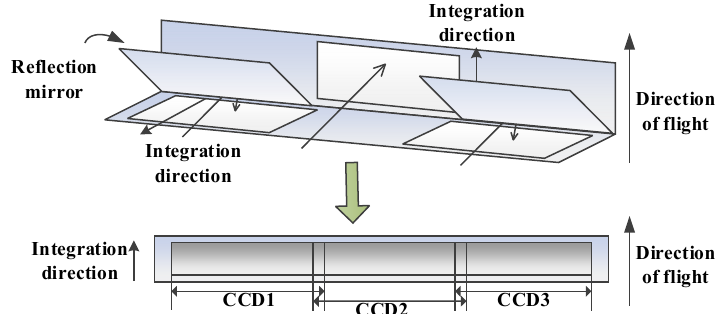
Figure 3. Focal plane of optical butting based on reflectors.